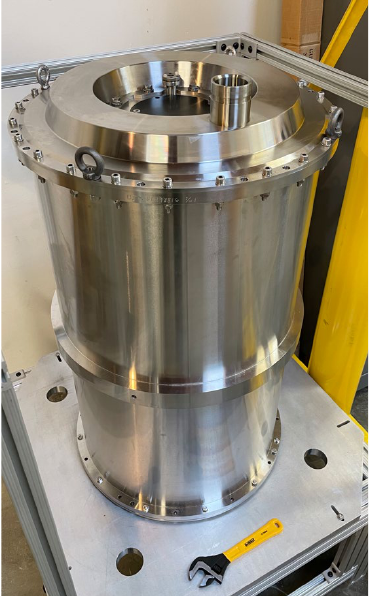
Fig. 12 . Stainless steel load cylinder assembly